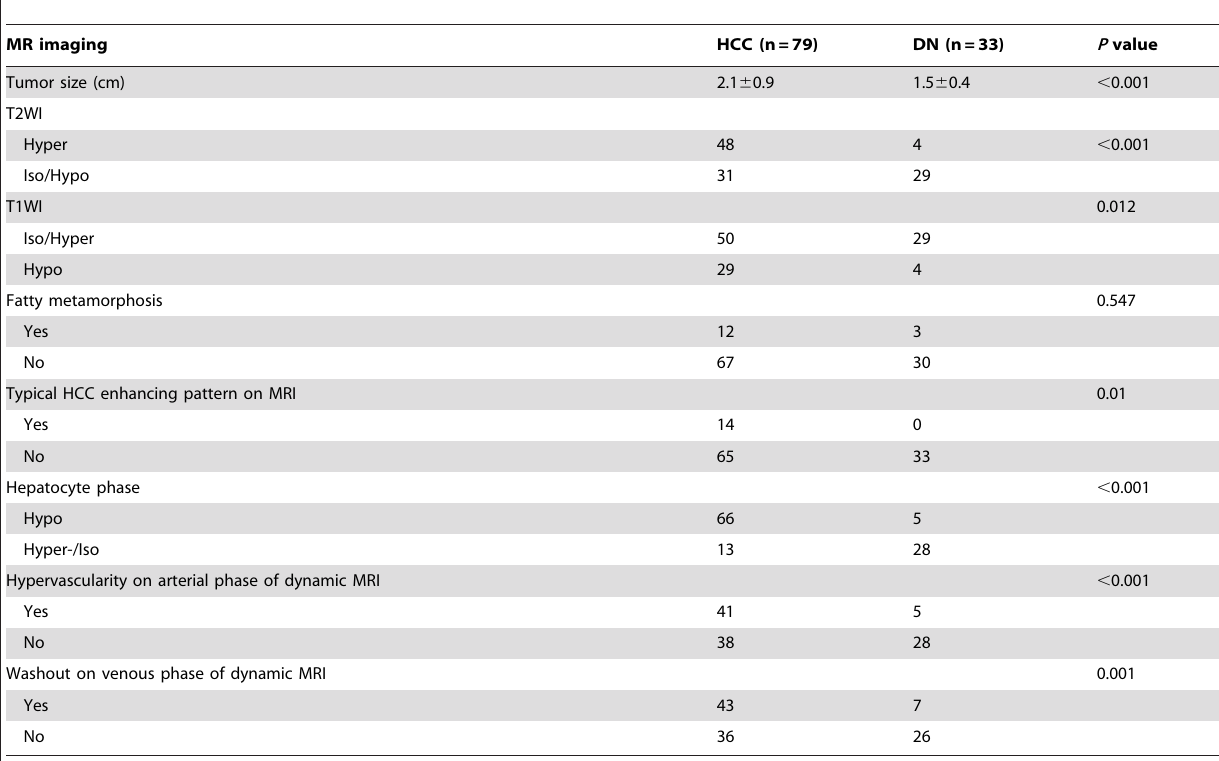
Table 3. MR characteristics of the 112 nodules showing atypical AASLD HCC enhancement patterns during CT dynamic studies.